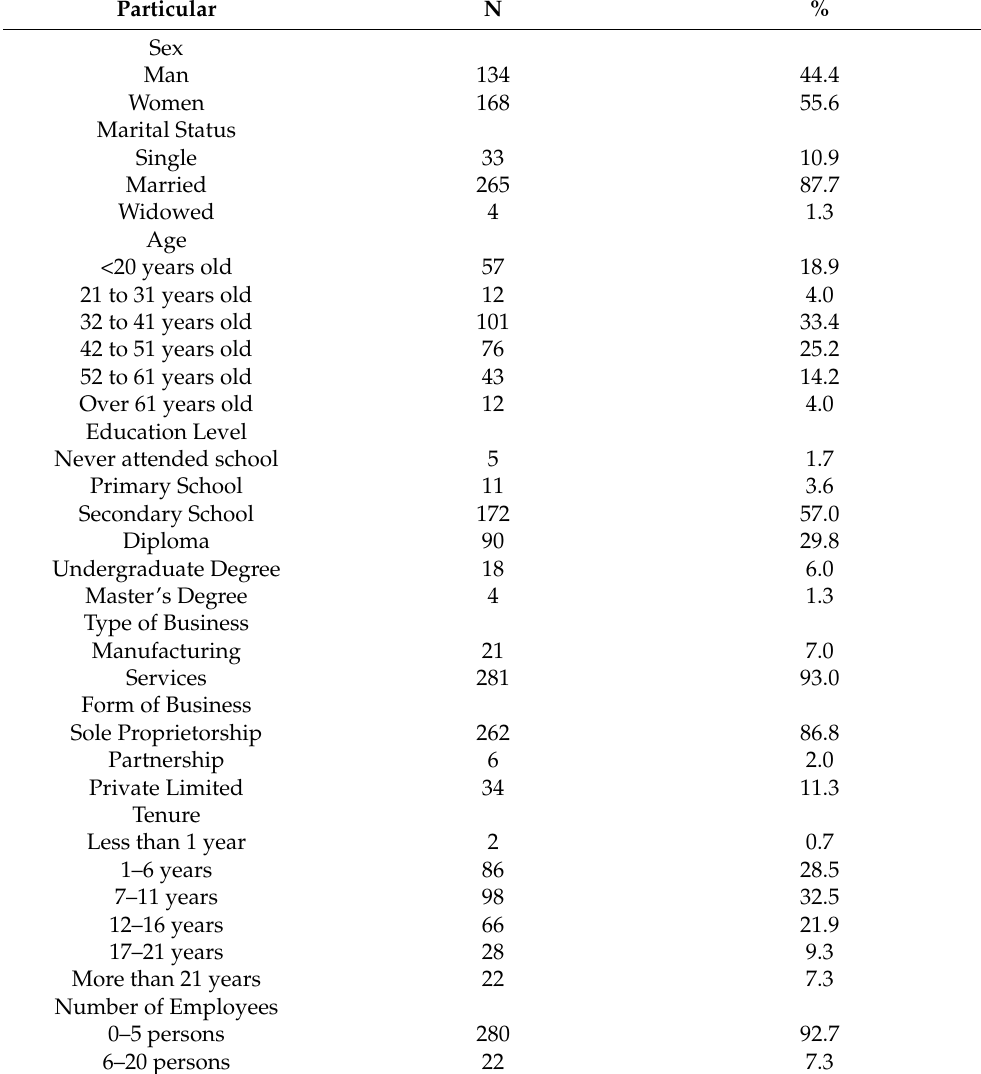
Table 1. Respondent